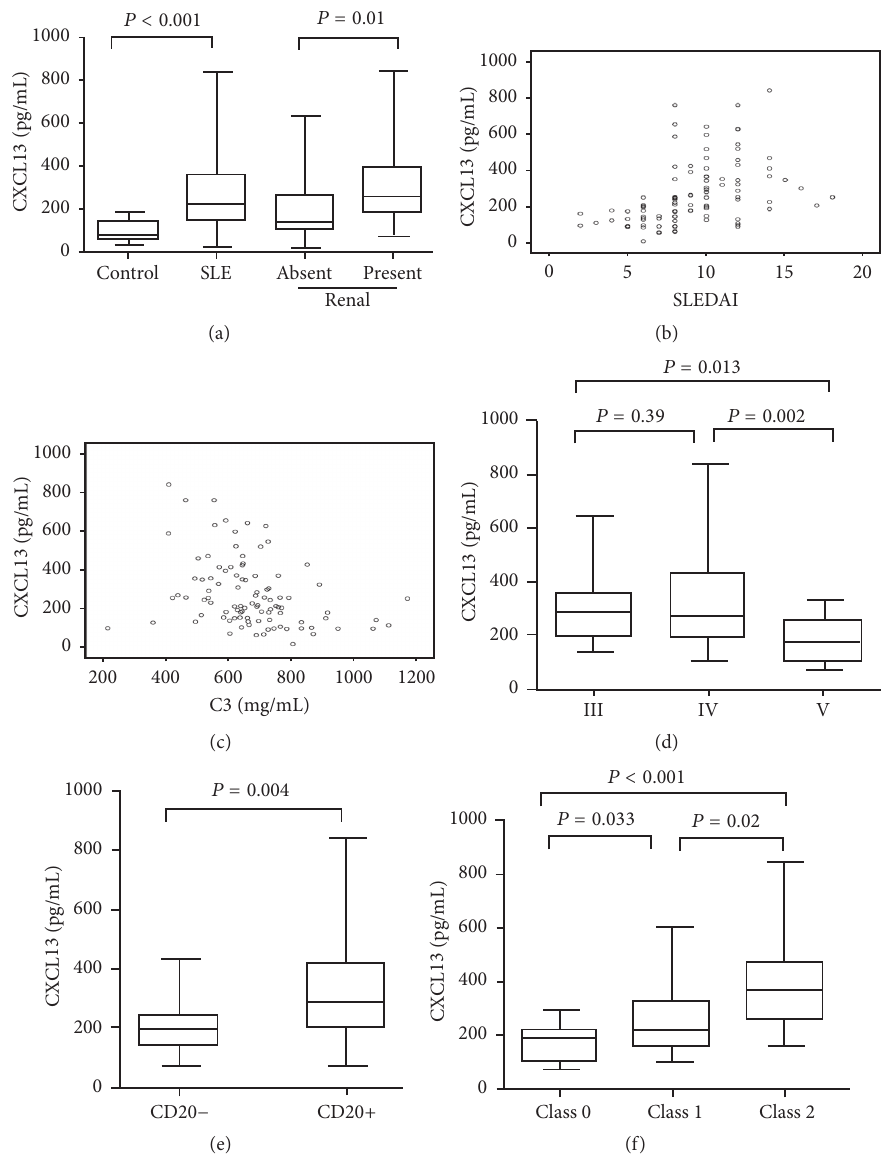
Figure 2: Changes in serum CXCL13 levels in LN patients. CXCL13 levels were increased in LN patients (a). Serum CXCL13 levels correlated with SLEDAI (b) and complement C3 (c). CXCL13 levels were different in LN patients with different WHO pathologic classifications (d), different CD20 expression (e), and different ELT class (f). Horizontal bars indicate median values and the boxes encompass the 25th percentile and 75th percentile, and whiskers indicate maximum and